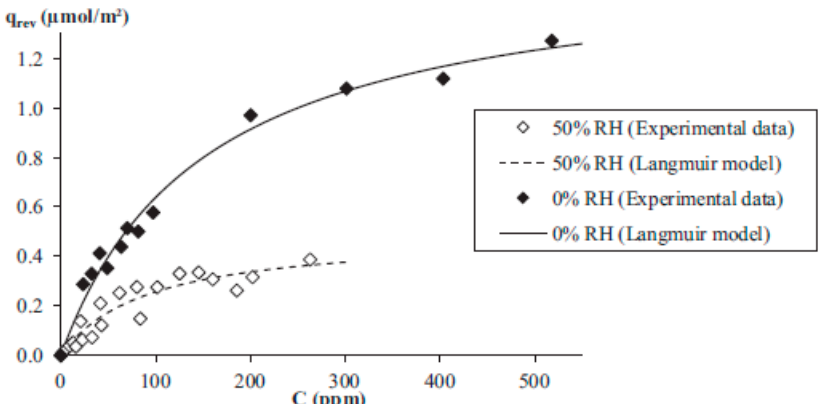
Figure 5. Acetaldehyde reversible adsorption on P25 TiO 2 isotherm under dry and humid conditions, at 23 °C. Reprinted from [20], Copyright 2020, with permission from Elsevier.